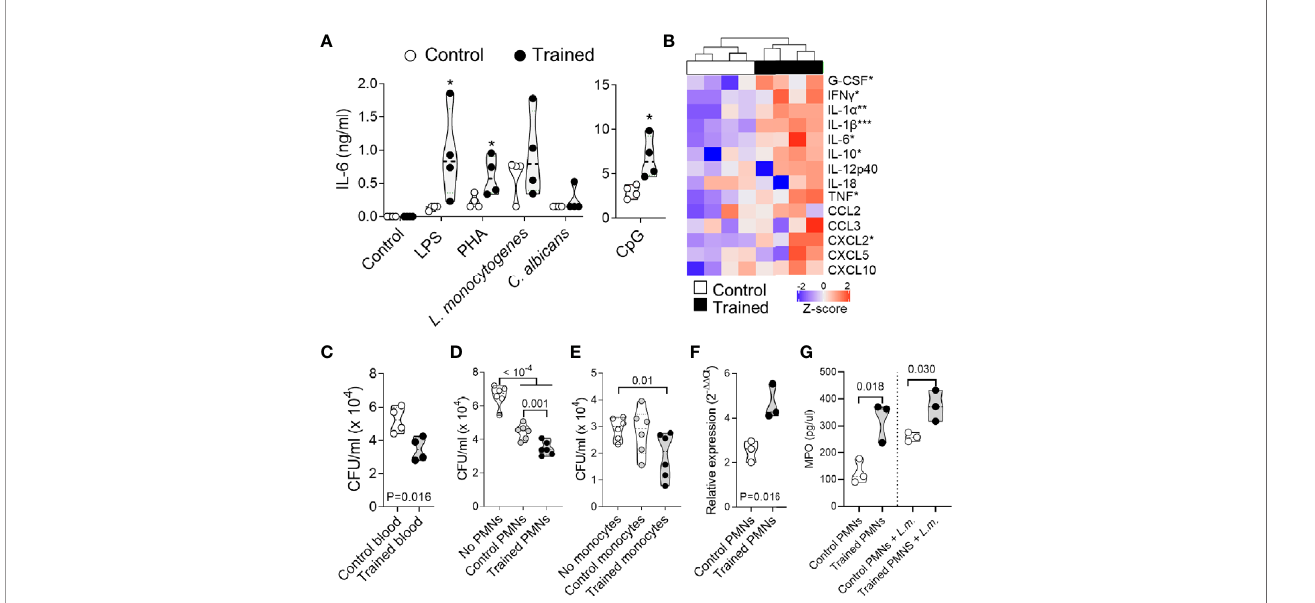
FIGURE 3 | Training for 9 weeks promotes whole blood antimicrobial responses. Blood was collected from control mice and mice trained 9 weeks before collection ( n = 4-5 mice per group). (A, B) Blood was incubated for 6 h with 10 ng/ml LPS, 1 m g/ml PHA, 10 m M CpG and 10 8 heat-killed L. monocytogenes and C. albicans . The concentration of IL-6 in blood supernatants was quanti fi ed by ELISA. Each dot of the violin plots represents data from one individual mouse, and the dashed horizontal lines the median. * P < 0.05 (A) . The concentrations of G-CSF, IFN g , IL-1 a , IL-1 b , IL-6, IL-10, IL-12p40, IL-18, TNF, CCL2, CCL3, CXCL2, CXCL5 and CXCL10 in blood supernatants were quanti fi ed by multiplex immunoassay (Luminex). Heatmap and hierarchical clustering of cytokine levels was performed using Z-score normalization (B) . (C – E) Blood (C) , PMNs (D) and monocytes (E) were incubated for 2 h with 6 x 10 4 , 6 x 10 3 and 1.8 x 10 3 CFU L. monocytogenes , respectively. Serial dilutions of blood or samples of lysed cells were plated on blood agar plates. After and incubation for 24 h, CFUs were enumerated (F, G) PMNs were culture 1 h with or without 10 8 heat-killed L. monocytogenes . Myeloperoxidase ( Mpo ) relative mRNA levels were measured by RT-PCR and normalized to actin housekeeping gene expression (F) . MPO concentrations in cell culture supernatants were quanti fi ed by ELISA (G) . Each dot in the violin plots represents data from one individual mouse and the dashed horizontal lines the quartiles. * P < 0.05; ** P < 0.01; *** P < 0.001 vs . control (A, B)